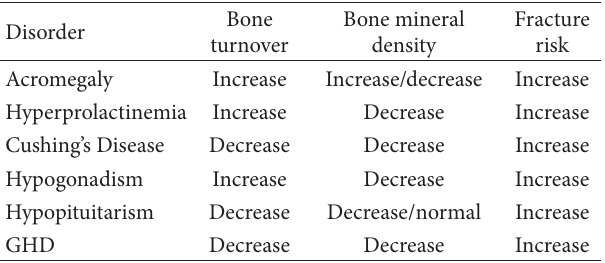
Table 2: The influence of pituitary disorders on bone turnover, bone density and fracture